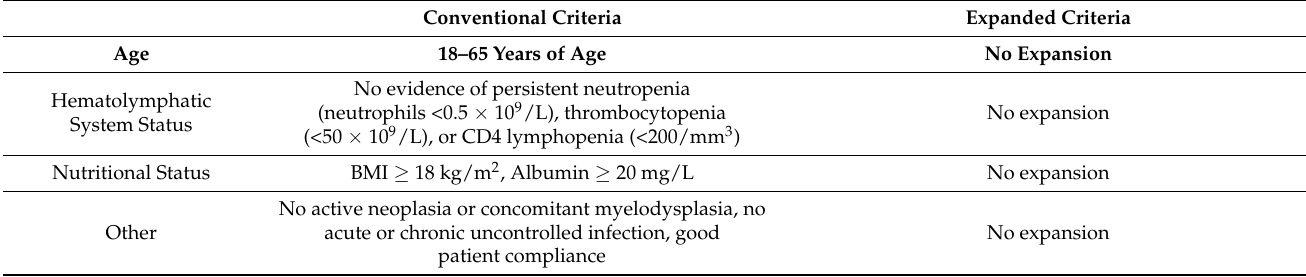
Table 2. Cont. Conventional Criteria Expanded